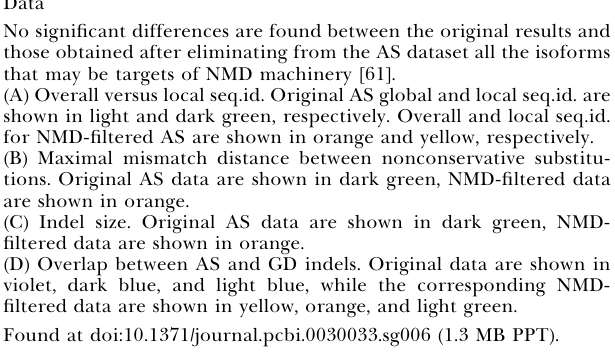
Figure S7. Excluding Potential Database Biases